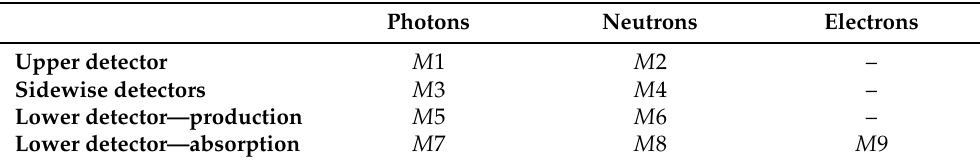
Table 1. The nine separate measurements for the different particle types and detector planes. Photons Neutrons Electrons Upper detector M 1 M 2 Sidewise detectors Lower detector—production Lower